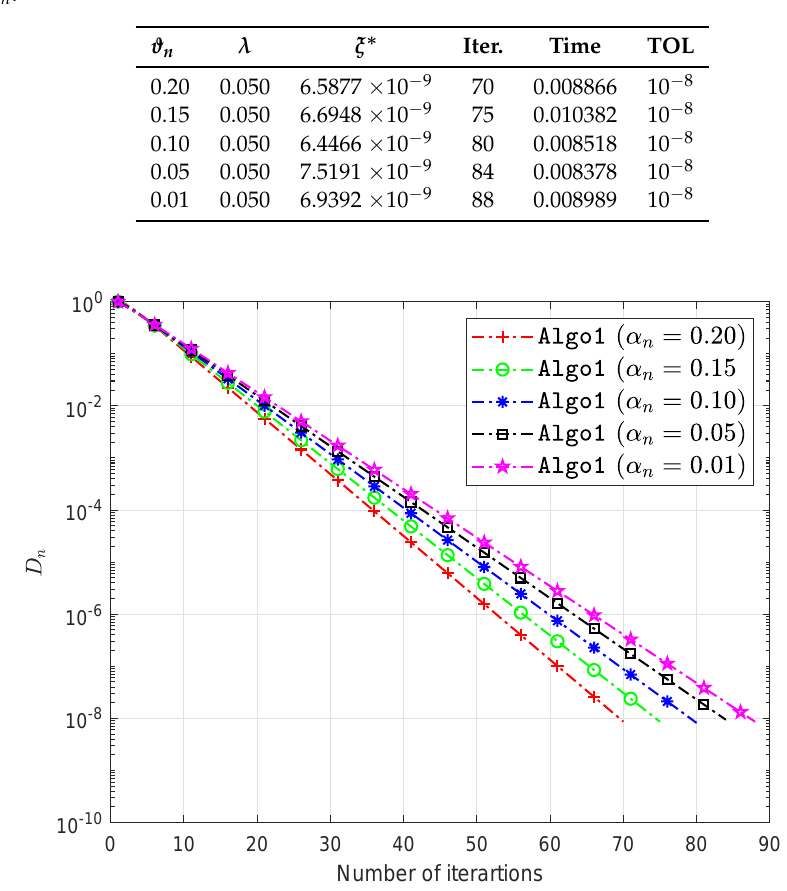
Figure 4. Experiment in Section 6.2.1: Algorithm 1 behaviour regarding different values of ϑ n .